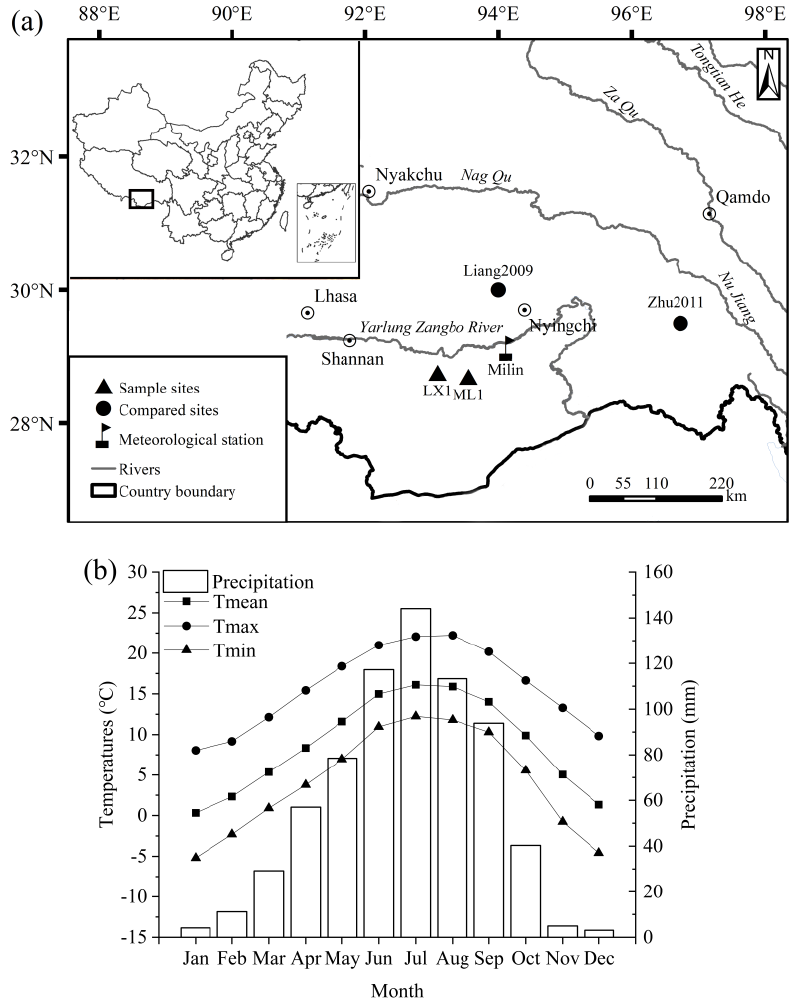
Figure 1. Locations of the tree ring sampling sites and the Milin Meteorological Station ( a ) and temperature and precipitation data from the Milin Meteorological Station during 1979–2020 ( b